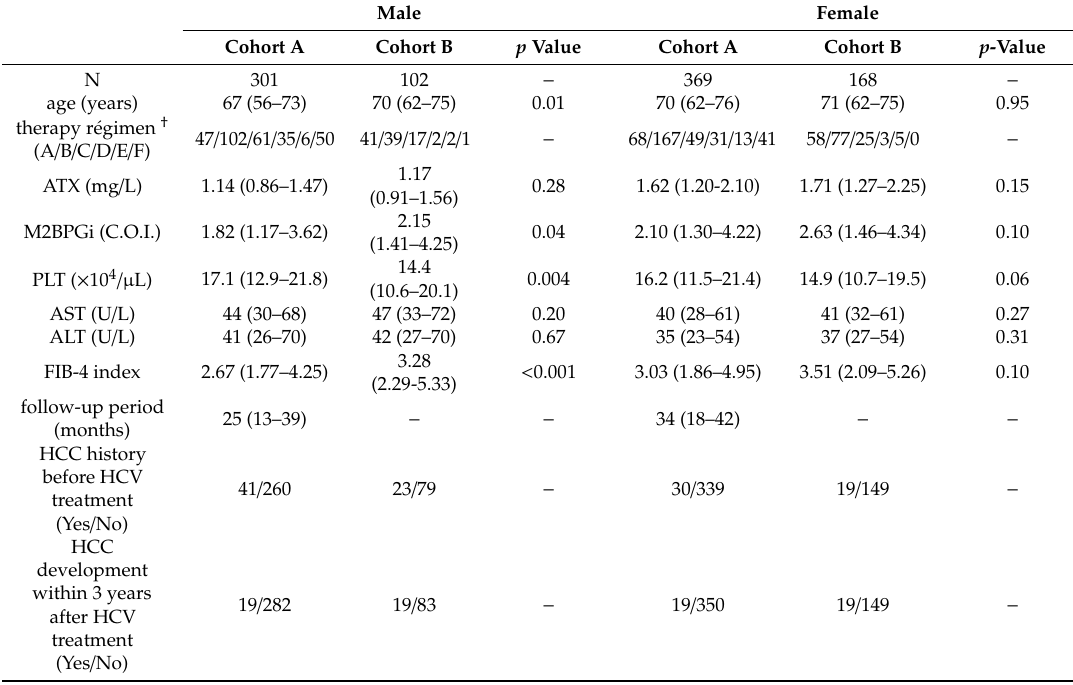
Table 3. Baseline